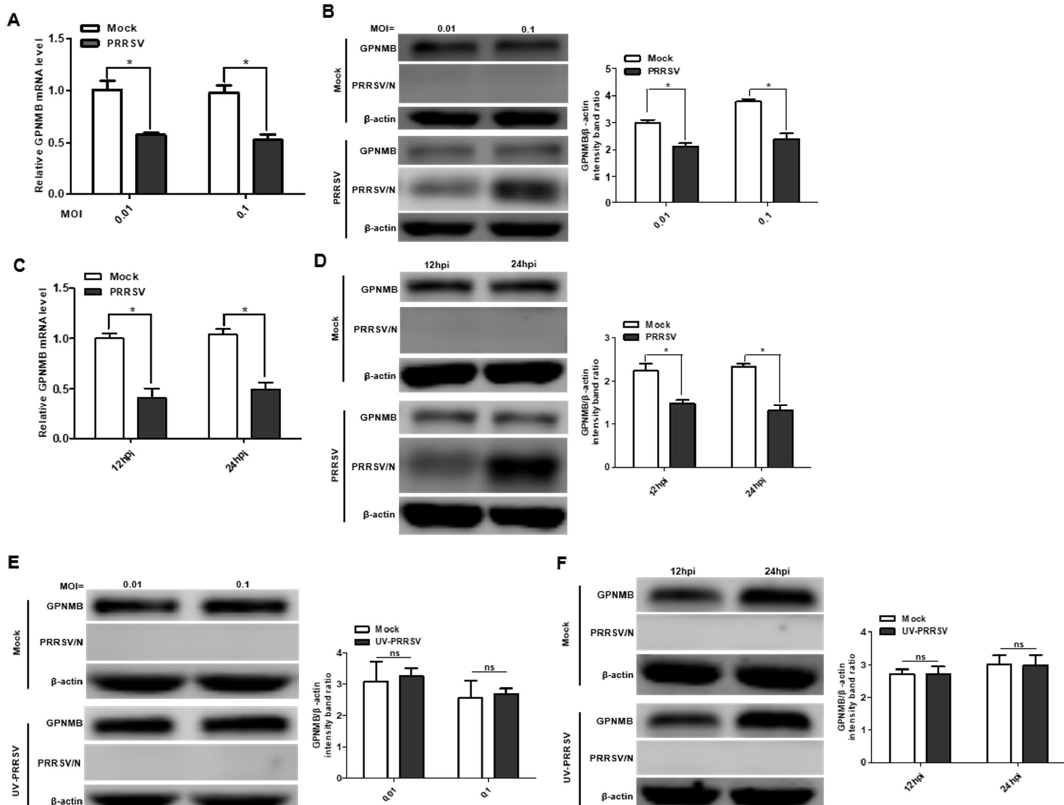
Figure 1. PRRSV infection alters GPNMB expression in cells. ( A – D ) PRRSV infection leads to the downregulation of GPNMB. Primary PAMs were infected with PRRSV at different MOI, and the samples were obtained at 24 h. The levels of GPNMB RNA and protein were determined by qPCR and Western blot ( A , B ). Primary PAMs were infected with PRRSV at an MOI of 0.1, and samples were obtained at different time points. The levels of GPNMB RNA and protein were determined by qPCR and Western blot ( C , D ). ( E , F ) The UV-PRRV incubation does not affect the GPNMB protein level. Primary PAMs were incubated with UV-PRRSV, and the cells were then further cultured for the indicated times. The cell lysates were subjected to immunoblo(cid:308)ing with the antibodies indicated. Results are representative of three independent experiments (means ± SD). ns (no significant difference) p > 0.05; * p < 0.05. The p -value was calculated using Student’s t -test.